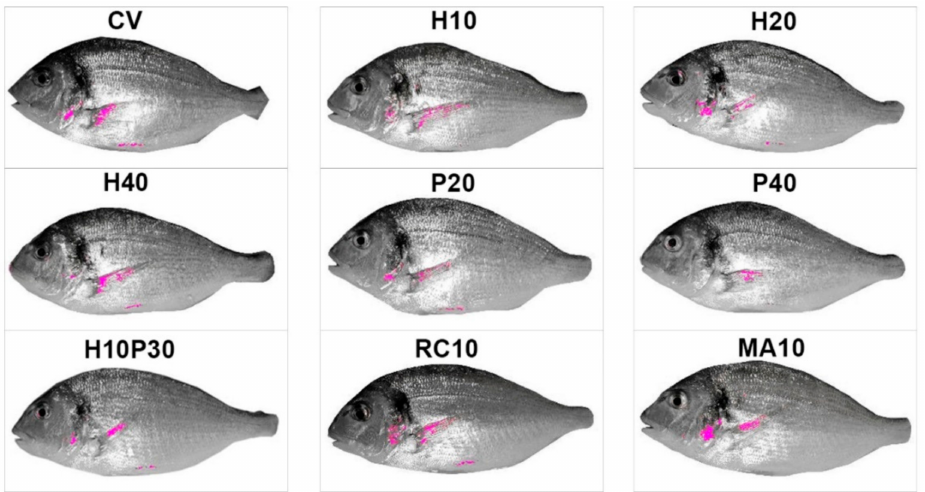
Figure 2. Average lateral profile patterns of pigmentation in gilthead seabream fed with experimental diets. Mean images for each treatment. Yellow pixels have been plotted in magenta to be more evident. CV: vegetable control; H: Hermetia illucens ; P: poultry by-product; RC: red swamp crayfish; MA: microalgae dried